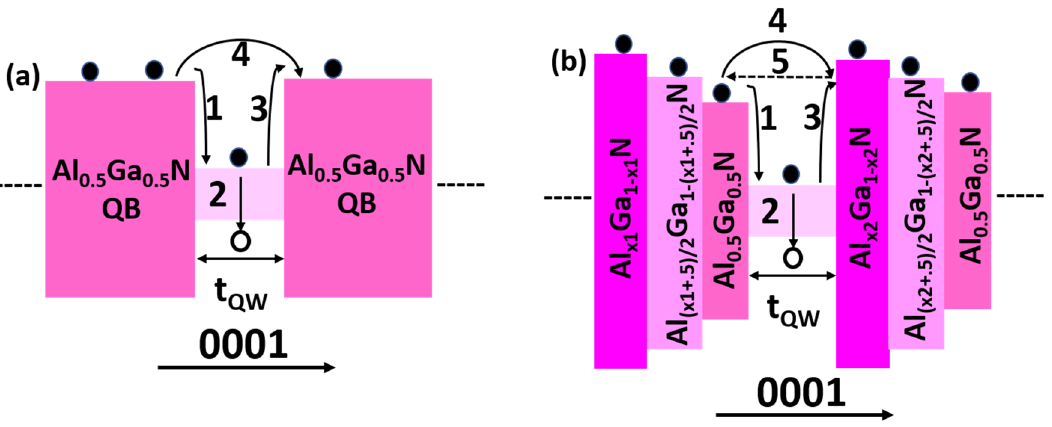
Figure 6. Schematic of Energy band diagram of ( a ) LED 1 and ( b ) LED 3.